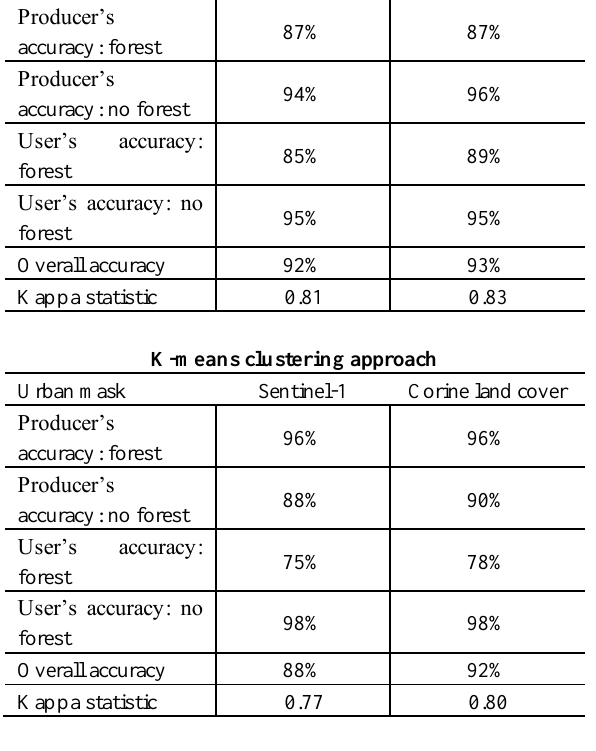
Table 1: Accuracy statistics for Sentinel-1 forest masks using ALS forest mask as reference.